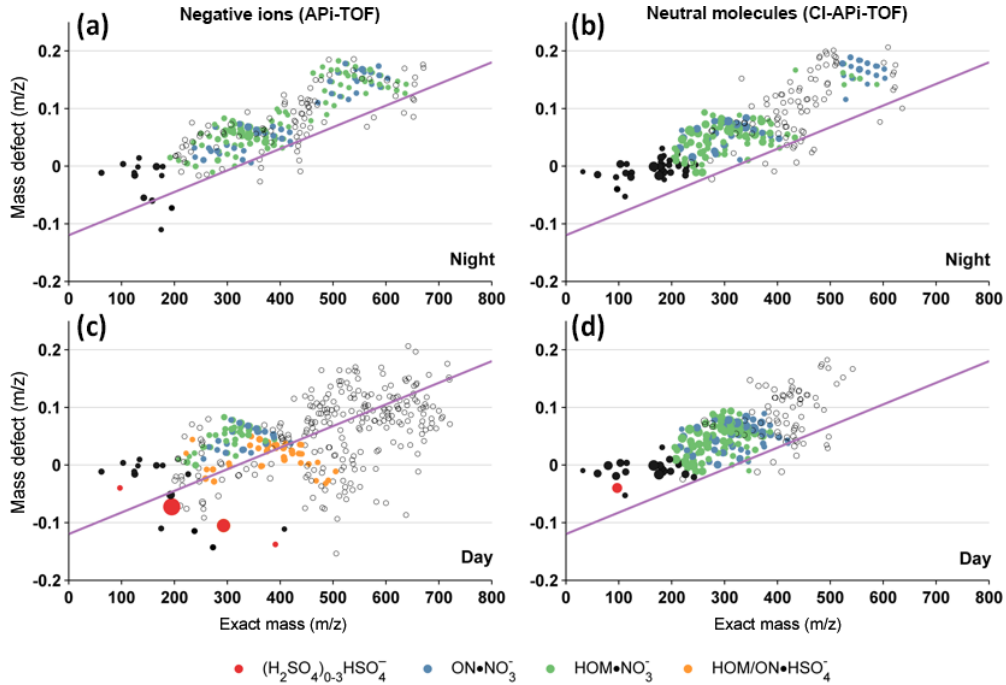
Figure 2. Mass defect plots for the neutral clusters and negative ions during 20 April 2013. Panels (a, b) show the night-time chemical composition of the negative and neutral clusters respectively. Panels (c, d) show the chemical composition during the day of the negative and neutral clusters respectively. The size of the circle represents the area of the peaks and is proportional to the detected amount. All four plots show the clusters/ligands as seen by the detector, therefore including the ligand (NO − are coloured according to their chemical composition. Open circles represent the unidentified compounds, while the black dots represent other identified peaks such as small organic acids. The violet line underlines the most oxidised HOMs detected by CI-APi-TOF as clusters with NO − ions. It is very likely that most of the unidentified negative ions that are placed below the line are HOM clusters with HSO − 3 or H 2 SO 4 HSO − acid 4